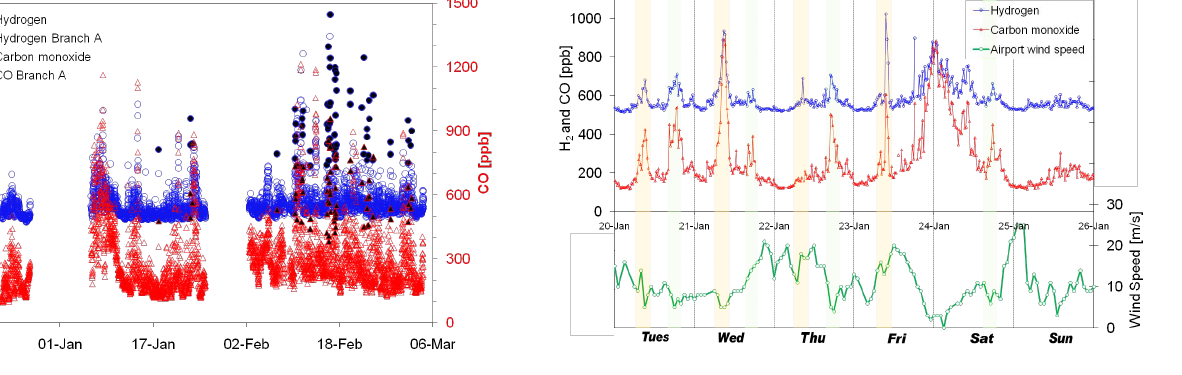
Fig. 2. Urban air measurements for H 2 and CO from the 15th of December 2008 until the 4th of March 2009 measured at Bristol in the United Kingdom.